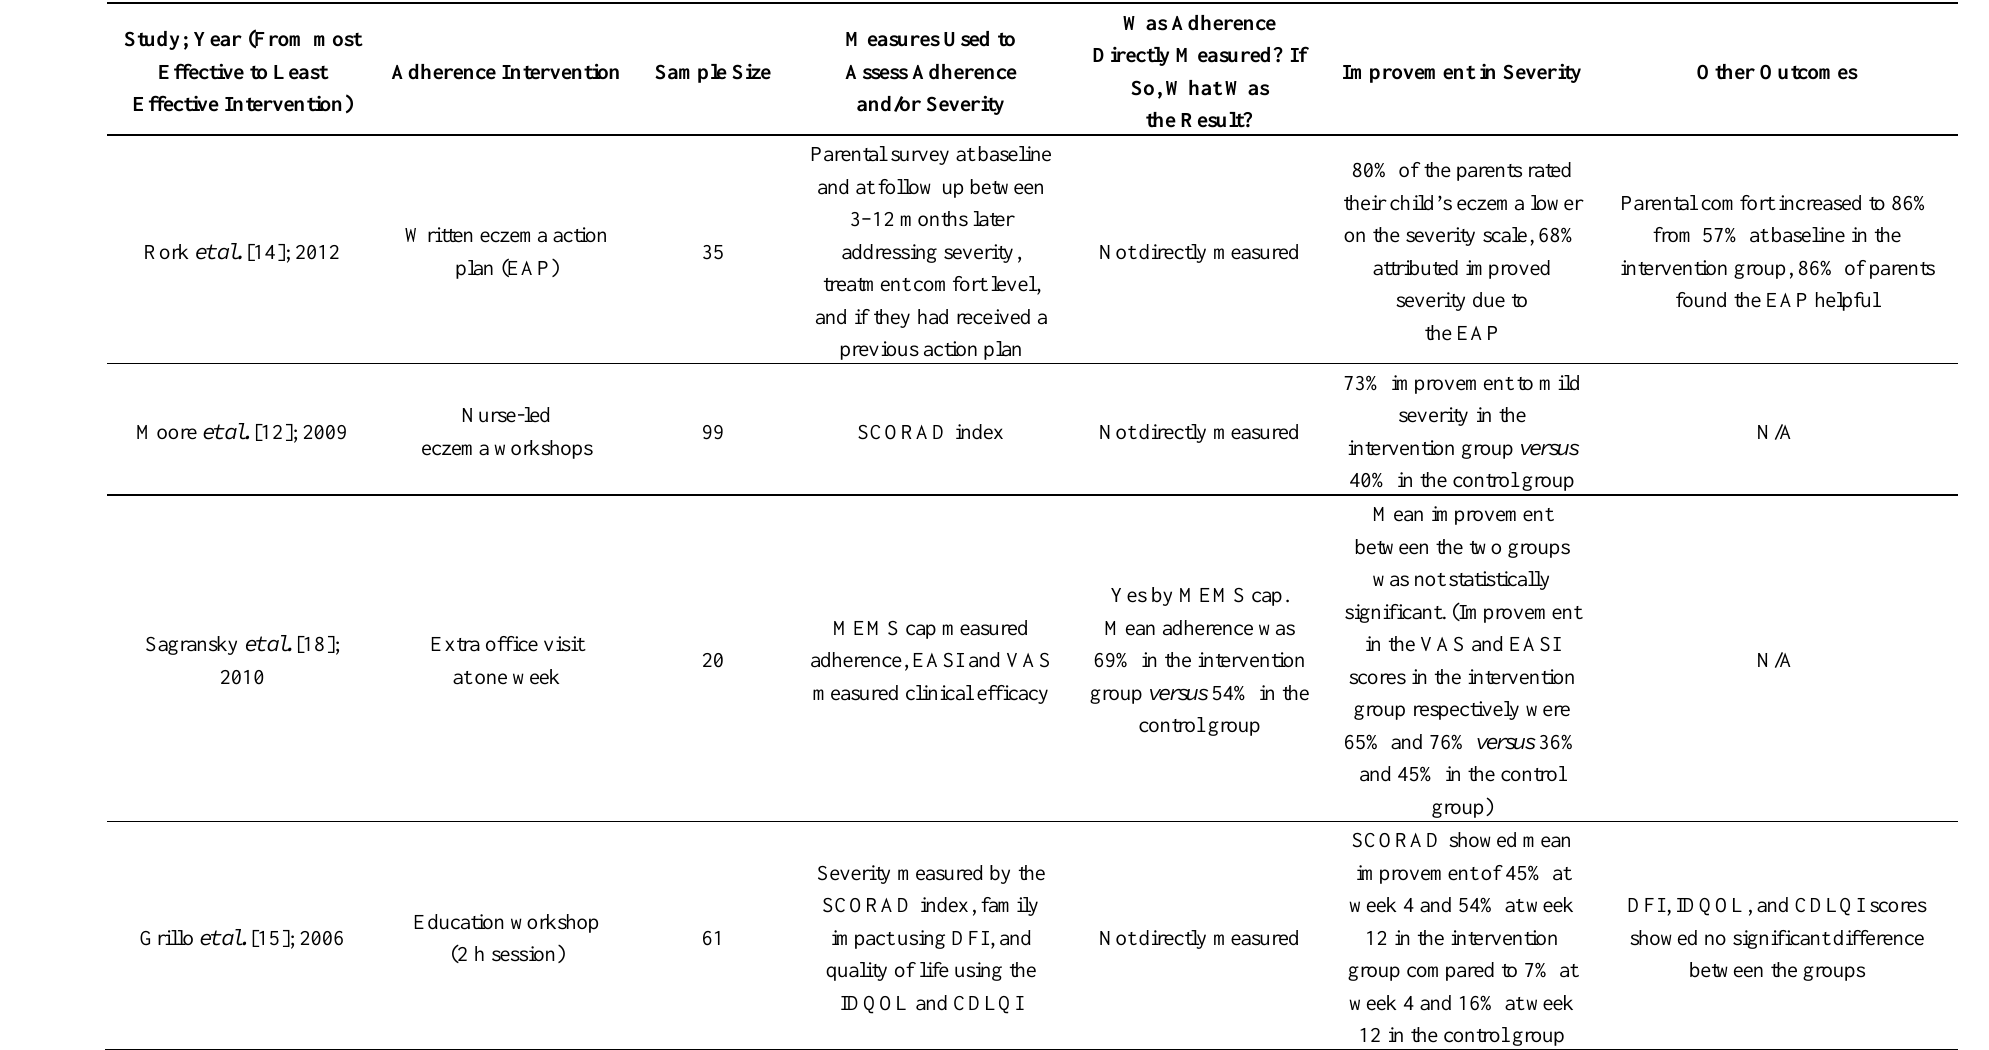
Table 1. Summary of data from seven studies on atopic dermatitis adherence